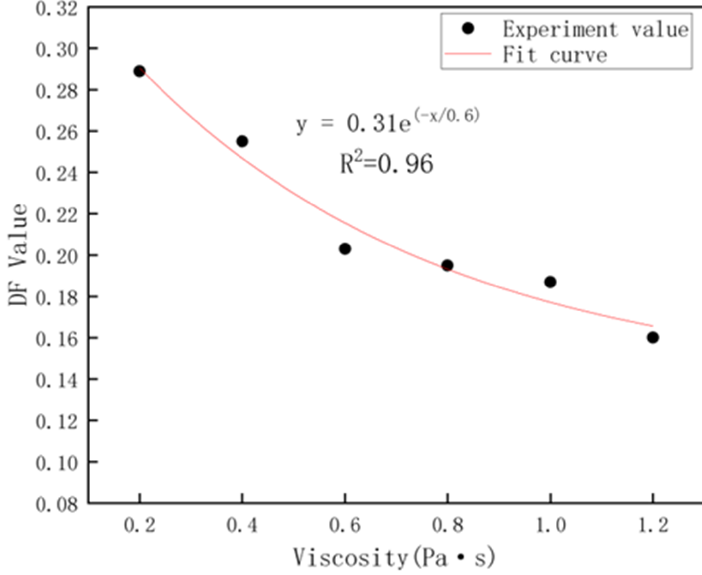
Figure 4. Relations between DF value and viscosity.